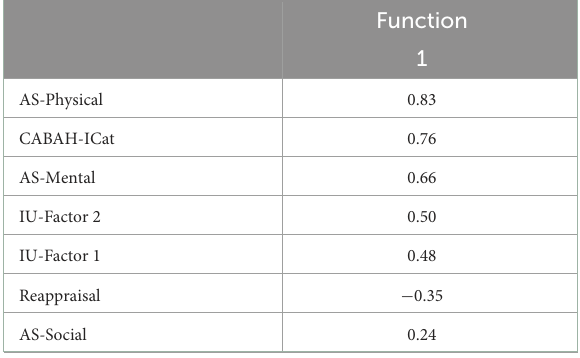
TABLE 5 Within-groups correlations between self-report discriminating variables and standardized canonical discriminant functions.